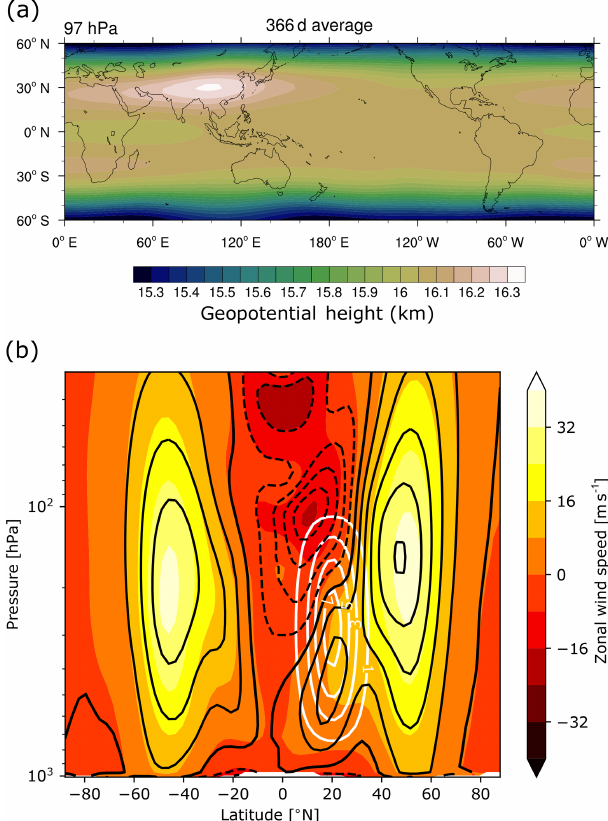
Figure 14. (a) Mean anticyclone structure via geopotential height (km) at ∼ 100hPa from 366d of the simulation (map included for orientation and scale purposes only; i.e., the simulation features no orography). (b) Vertical cross section of zonal-mean wind (color coded) and wind in the anticyclone region averaged over 60–120 ◦ E (black contours; in steps of 8ms − 1 ; negative values are denoted by dashed lines). White contours show the maximum along the longi- tudes of the implied heating function (in Kd − 1